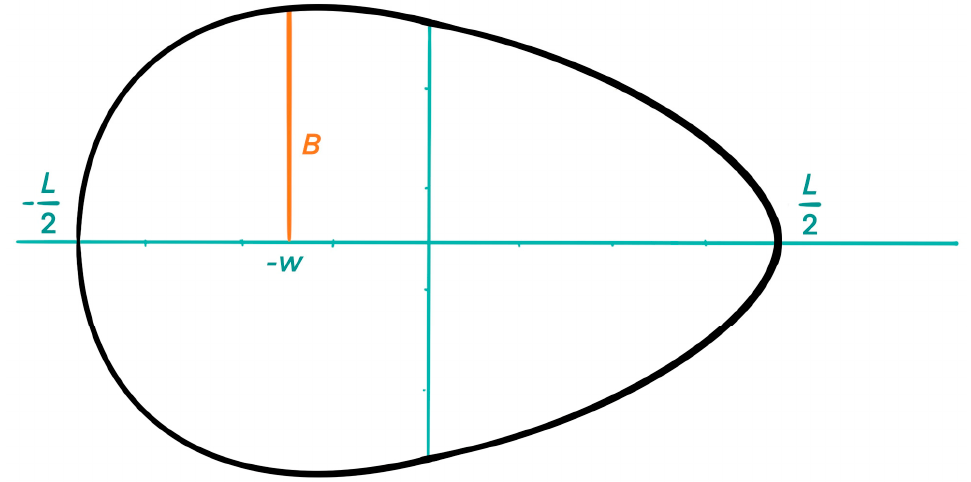
Figure 6. Scheme of an egg curve with marked parameters.